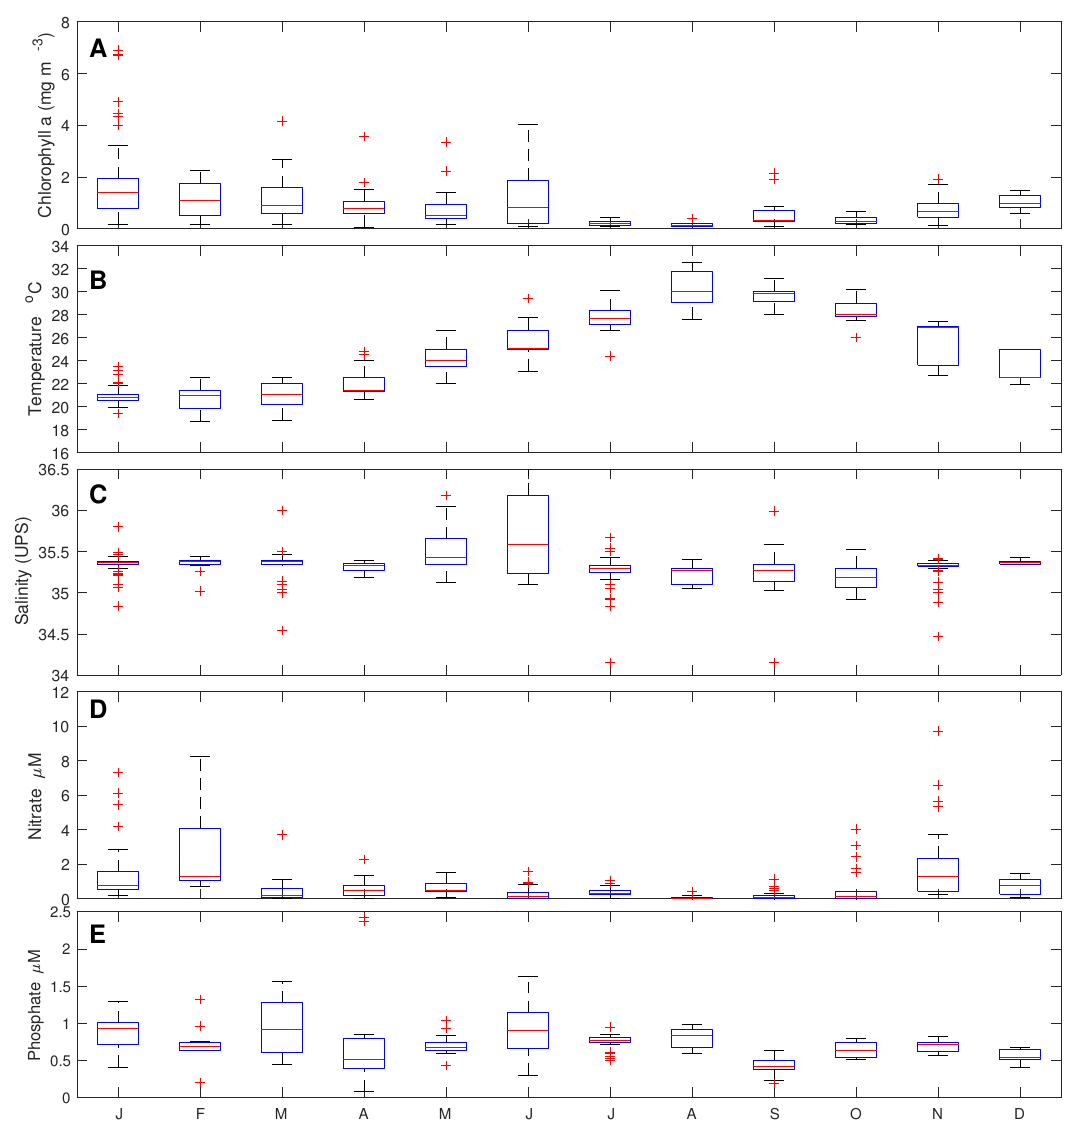
Figure 2. Seasonal cycle of in situ surface data (25–75% percentiles, means, and extreme data) recorded in Bahía de La Paz (BLP). ( A ) chlorophyll-a (Chl-a), ( B ) temperature, ( C ) salinity, ( D ) nitrates, and ( E )